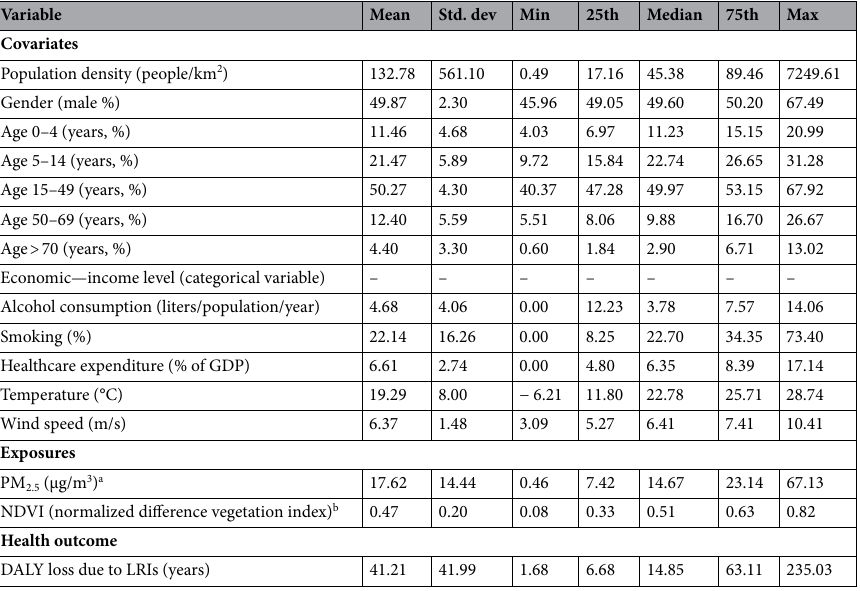
Table 1. Baseline characteristics of variables. a Main exposure. b Exposure for subgroup